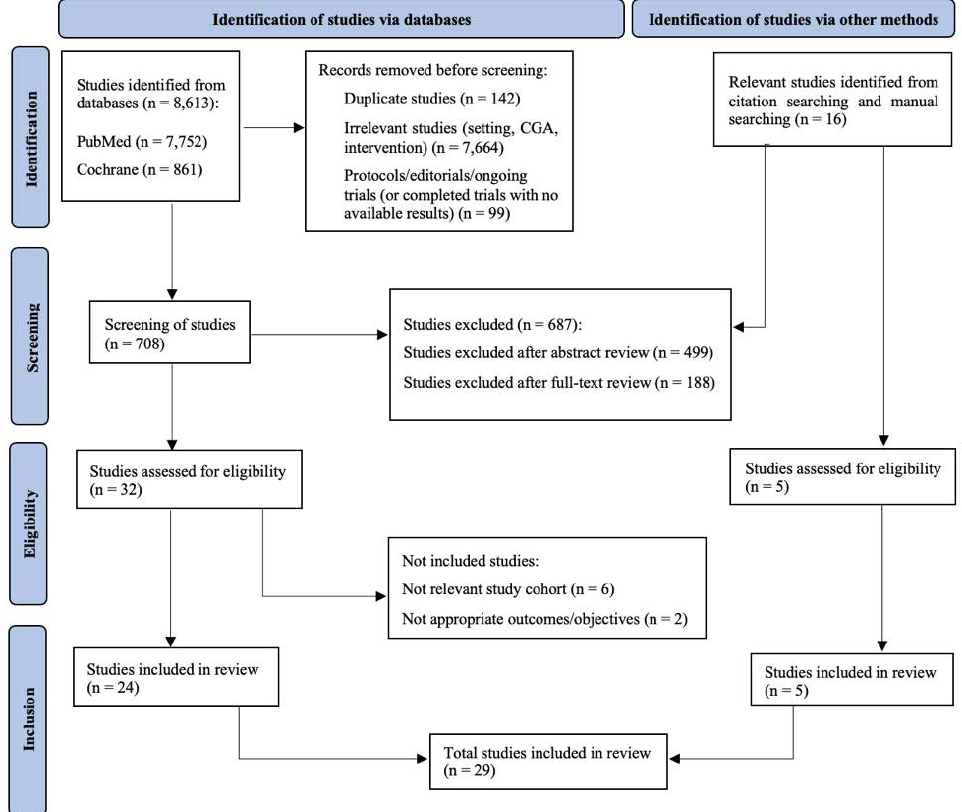
Figure 1. Review